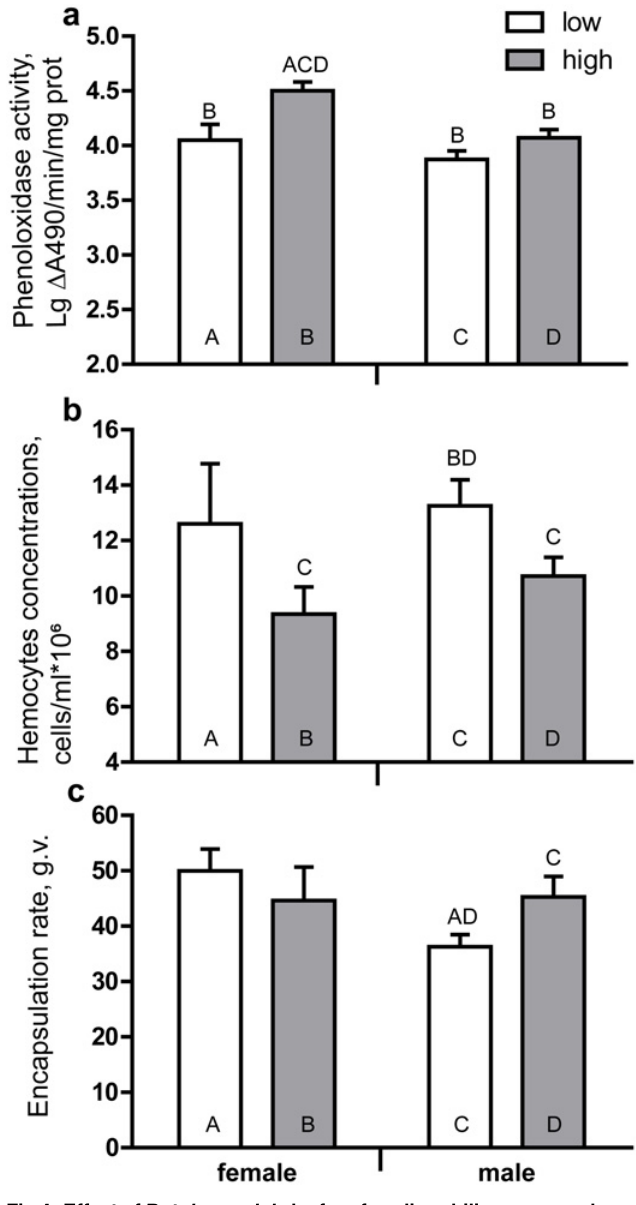
Fig 4. Effect of Betula pendula leaf surface lipophilic compounds on larval innate immunity parameters. Activity (mean ± SE) of phenoloxidase in hemocytes-free hemolymph of hemolymph (a), total hemocyte count (mean ± SE) in hemolymph (b) and encapsulation rate (mean ± SE) of hemolymph (c) of fourth instar Lymantria dispar larvae reared on Betula pendula leaves with low and high concentrations of surface lipophilic compounds is presented. The data were pair-wise compared by the post hoc Fisher LSD procedure. The letters above the bar mean the significant differences (at P < 0.05) to be compared with the bars abbreviated by the same letters within the